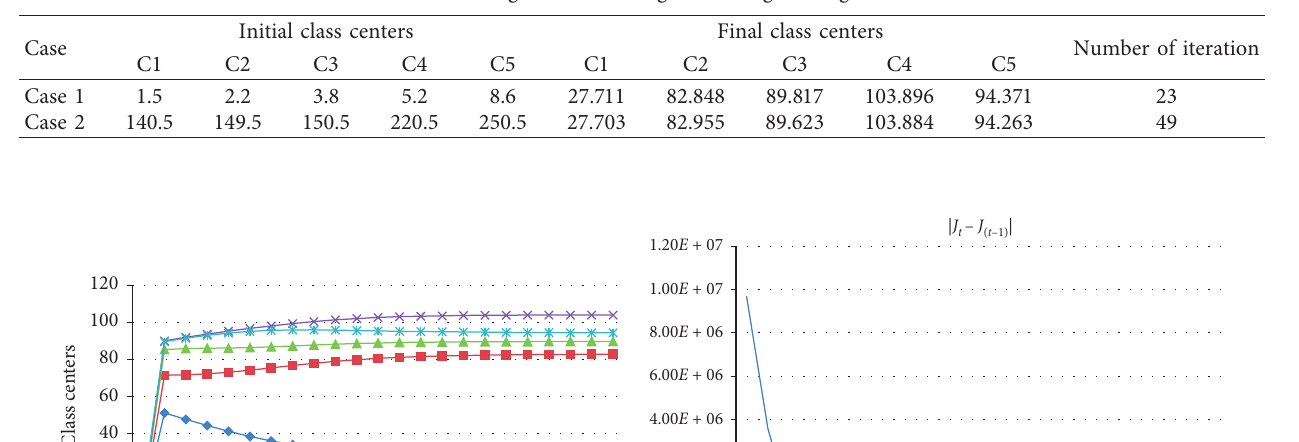
Table 1: Different states of the DT2FL algorithm for image clustering starting from class centers initializations.